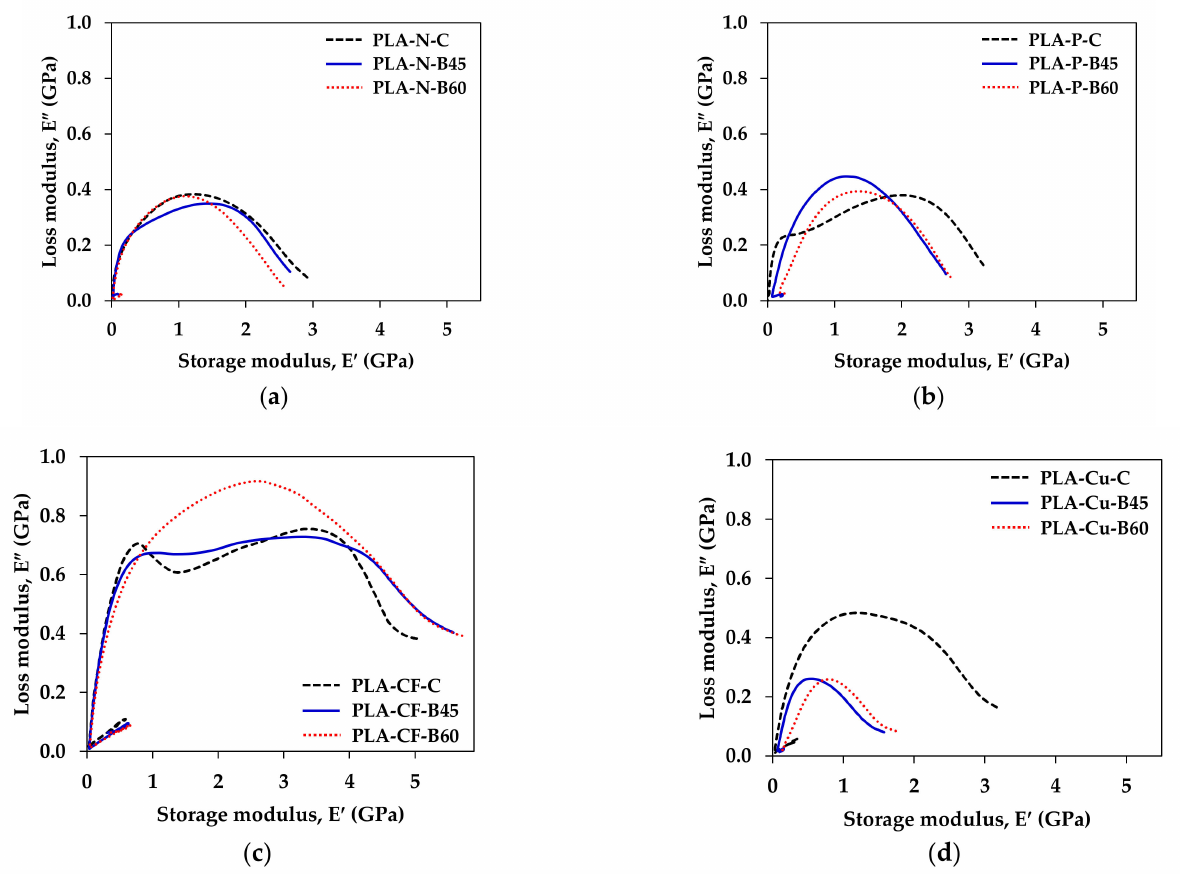
Figure 9. Cole–Cole plot of compression molded sheet and 3D printed samples: ( a ) PLA-N; ( b ) PLA-P; ( c ) PLA-CF; and ( d ) PLA-Cu.